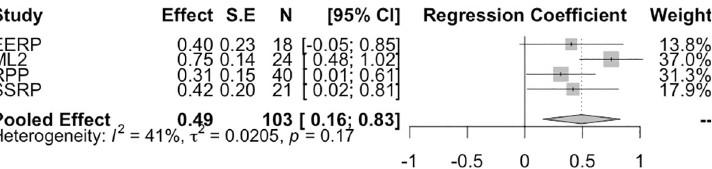
Fig 5. P-value and replication outcomes. The relationship between p-value category and replication is robust to a meta-analysis, with a pooled effect of 0.49. There is no evidence for heterogeneity between studies ( I 2 = 41%, 95% CI [0%, 80%], τ 2 = 0.0205, 95% CI [0, 0.49] and Q (3) = 5.06, p = 0.17), however with only 4 studies included in the meta- analysis there may be low power to detect heterogeneity. For all studies, the effect is in the same